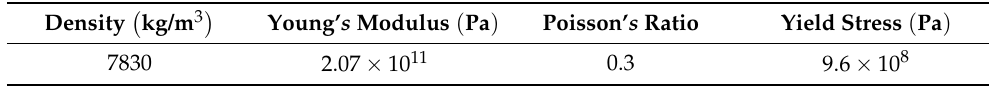
Table 1. The node-set at the bottom layer of the base is set as the node-set, and the SPC_SET is used to impose full constraints on the node-set. The simulation time is set as 0.6 s and the simulation output step size is set as 0.002 s. After setting the boundary conditions, the finite element solution is completed by calling the K file through ANSYS/LS-DYNA solver. Table 1. Material model parameters of steel plate. Table 1. Material model parameters of steel plate.